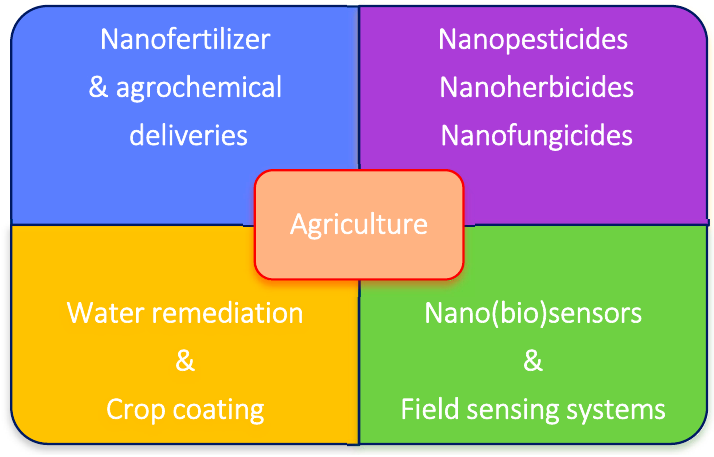
Figure 7. Application possibilities of NTs in agriculture.